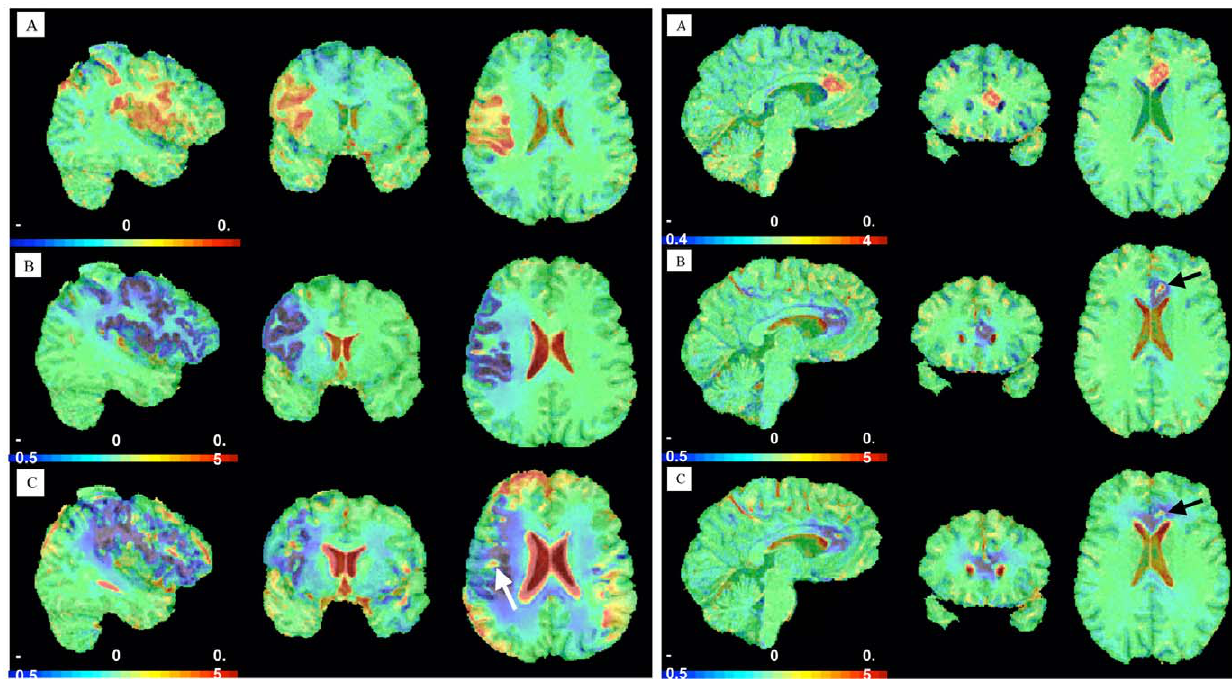
Figure 3. VGM volume fields in Patients 12 (left) and 13 (right). Left: The first MRI, obtained within 48 hours after stroke onset, is compared to MRIs obtained 4 days (A), 3 months (B), and 5 years (C) later. After 5 years, volume increases can be detected in a spotlike distribution (arrow) within the infarcted area. Right: Volume fields are shown from MRIs obtained 5 days (A), 3 months (B), and 5 years after the first MRI had been obtained immediately after stroke onset. A small area of volume increase (arrow) within the original ischemic zone, first seen after 3 months, still